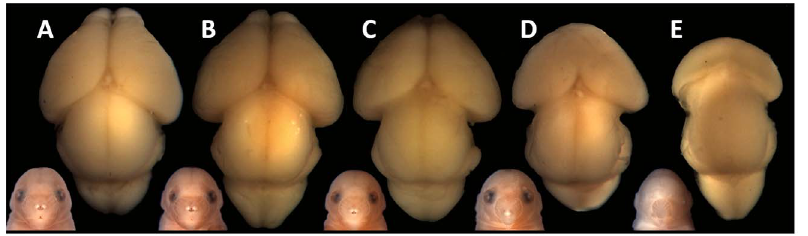
Figure 4. Facial dysmorphology predicts medial forebrain deficiency. Superior views of dissected brains are shown for a normal fetus (A) and for representative examples of each category of facial dysmorphology (B-E). Medial facial deficiency was associated with increasing hypoplasia of the cerebral cortices (B-E), increasing hypoplasia (B, C) or absence of the olfactory bulbs (D, E), and incomplete division of the forebrain (D, E).